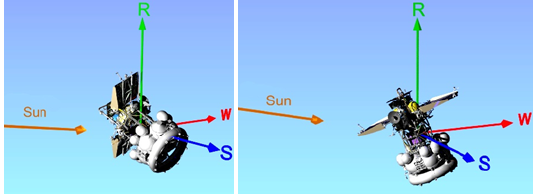
Figure 6. Orientation of the spacecraft «Phobos-Grunt» on 24.12.2011 (on the left) and on 25.12.2011 (on the